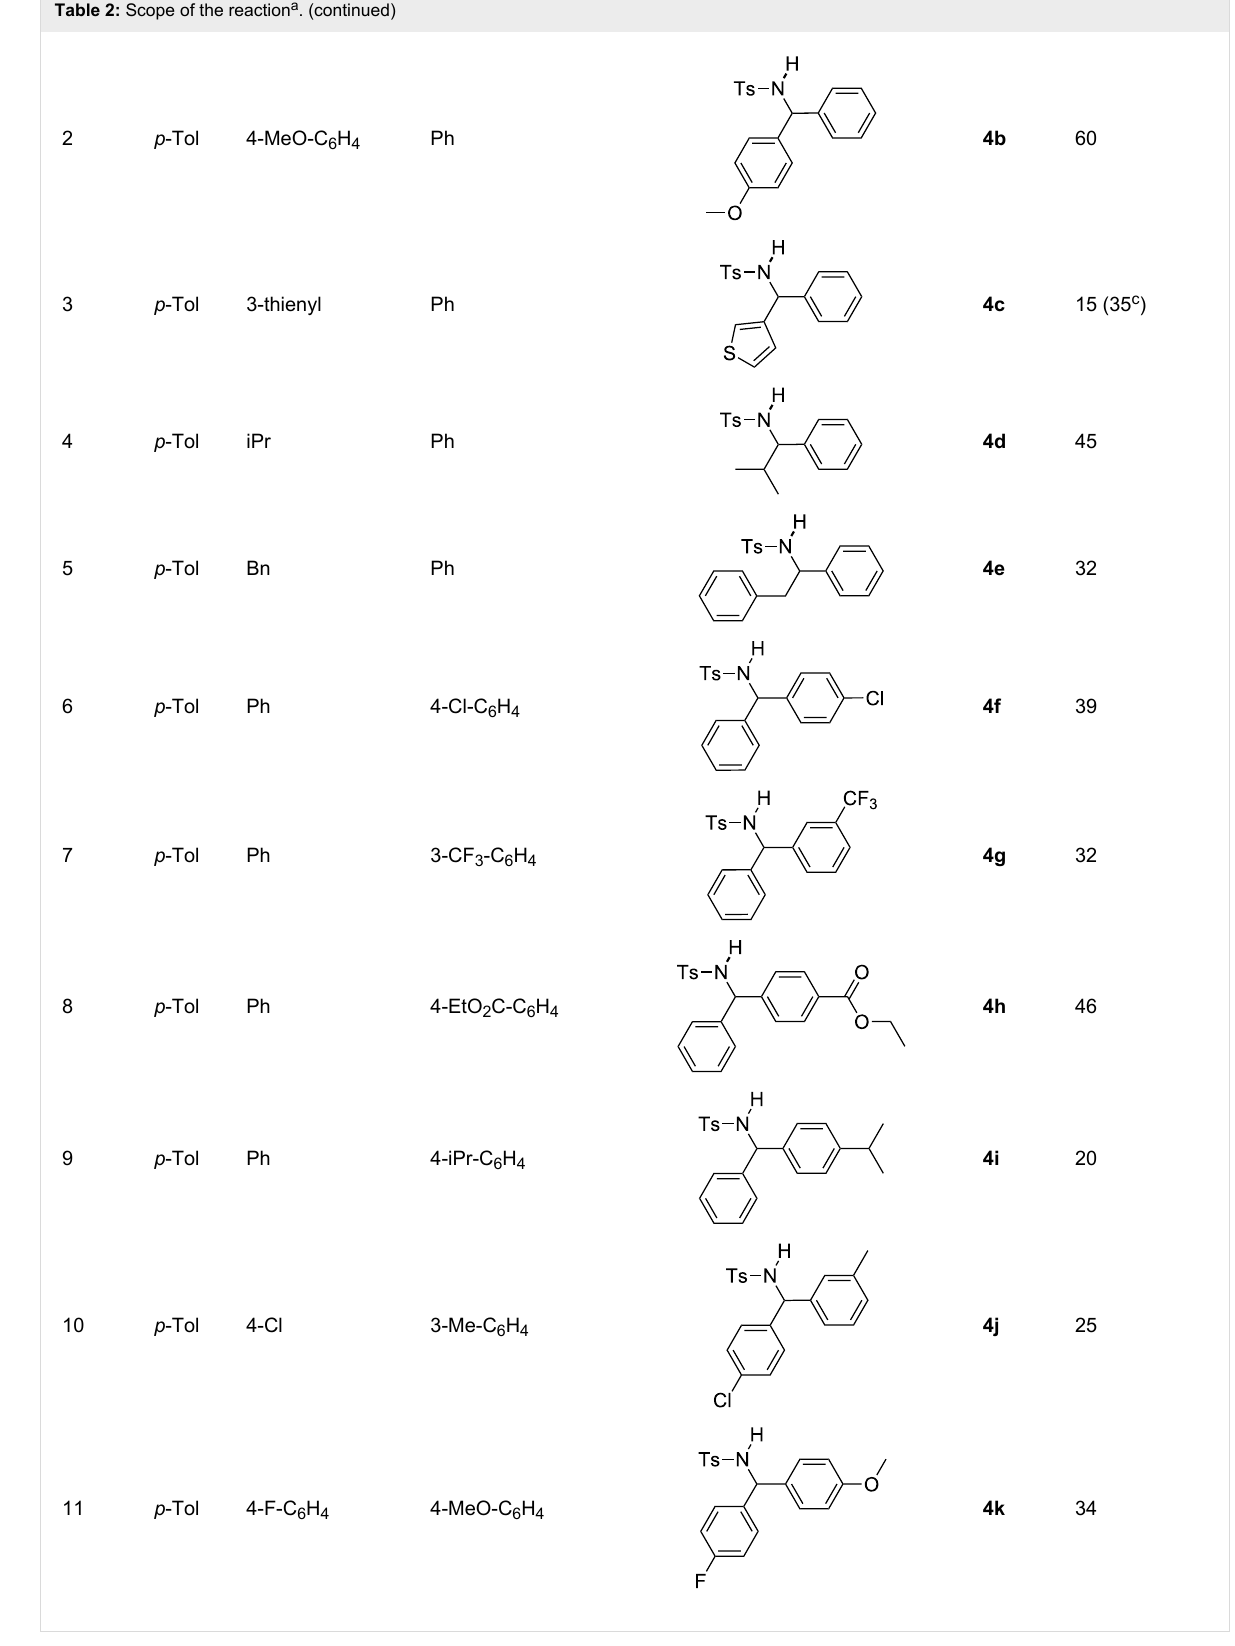
Table 2: Scope of the reaction a .